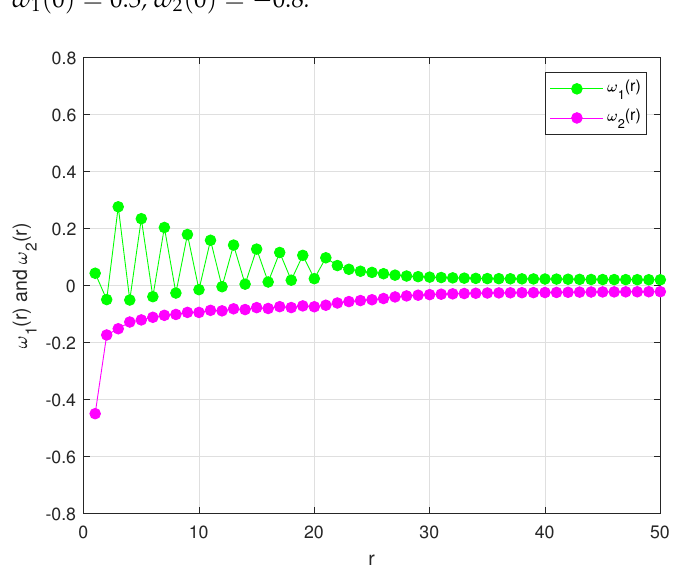
Figure 2. State responses of the system in